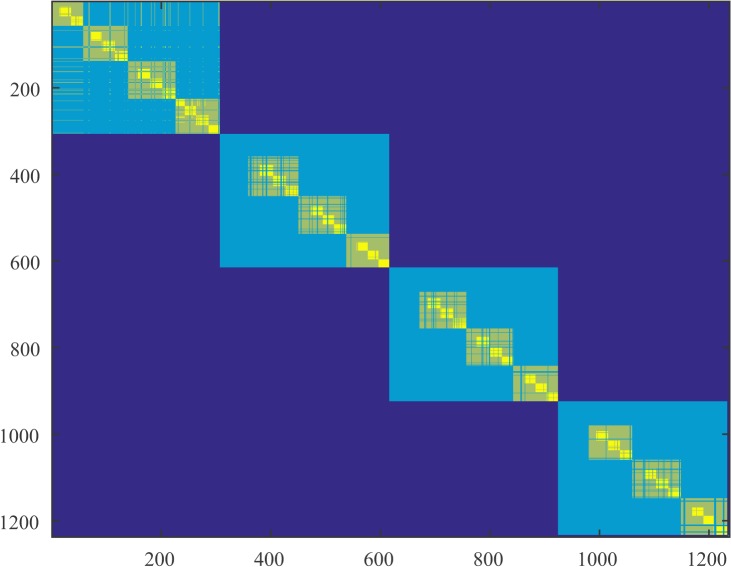
Modified co-affinity matrix during question blank state.Modified co-affinity matrices for subject 1 during the segment that the subject was exposed to a blank screen after the question. We display only the first 1200 vertices. The block diagonal organization seems to be segmented; vertices are now distributed in different clusters.